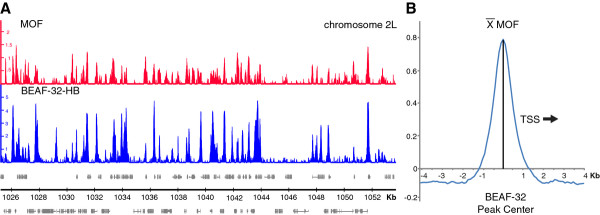
Comparison of MOF and BEAF-32 binding sites. (A) MOF (red) and BEAF-32 (blue) log2 enrichment profiles in a typical region of chr2L. Scale bar show the genomic positions in Kb. Genes expressed from left to right are shown above the horizontal line and the genes expressed in the opposite direction are shown below the line. (B) The average MOF enrichment values in 100 bp bins surrounding promoter peaks of BEAF-32 in autosomes. Promoters where aligned so that the TSS will always be to the right of the BEAF-32 peak in the figure.